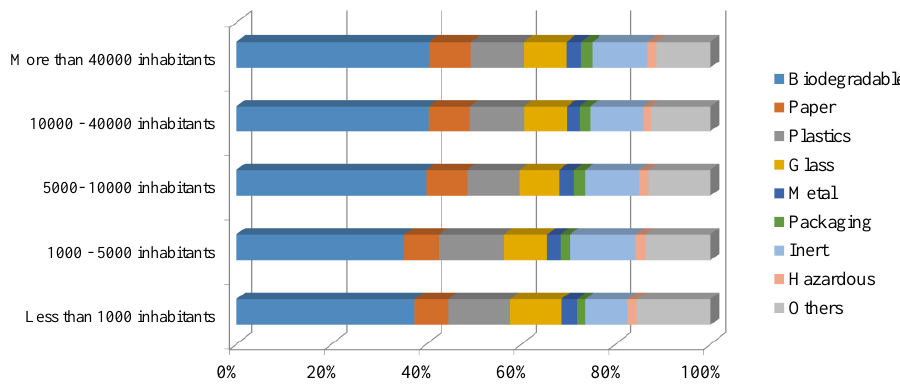
Fig. 2. Results of waste composition by city